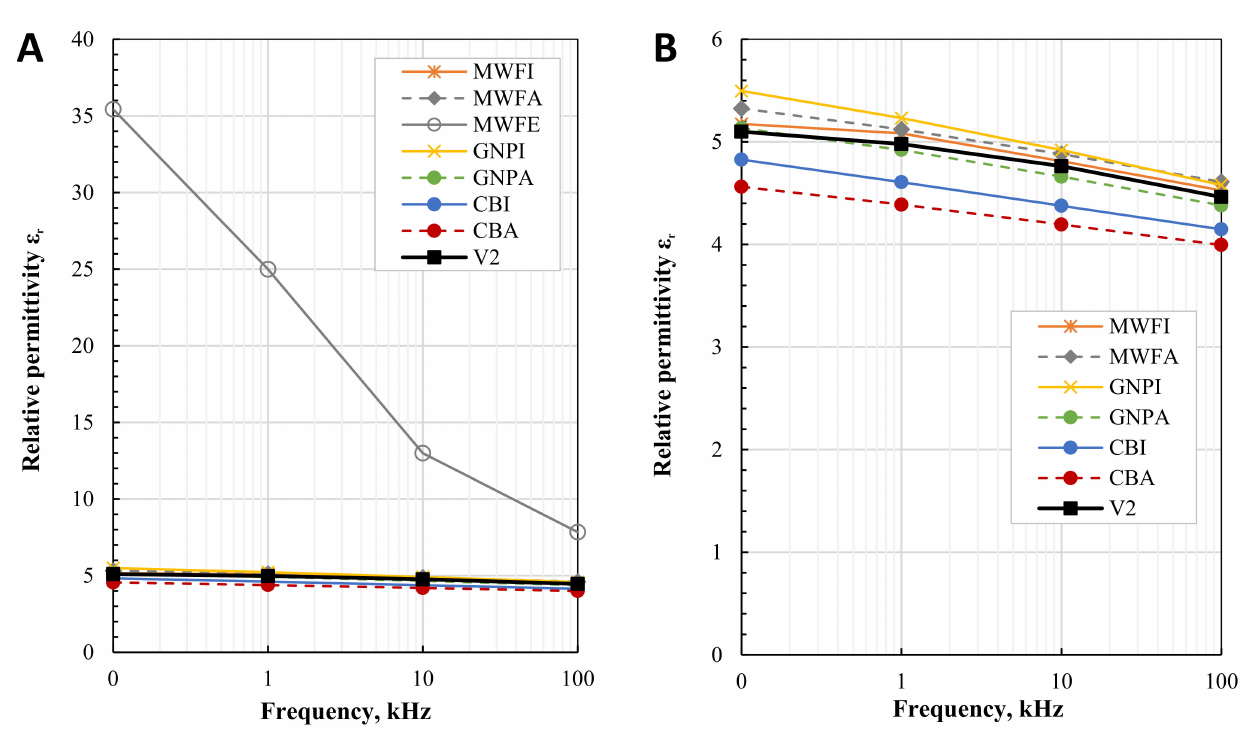
Figure 10. Relative permittivity ε r of: ( A ) all composites; ( B ) composites without MWFE.